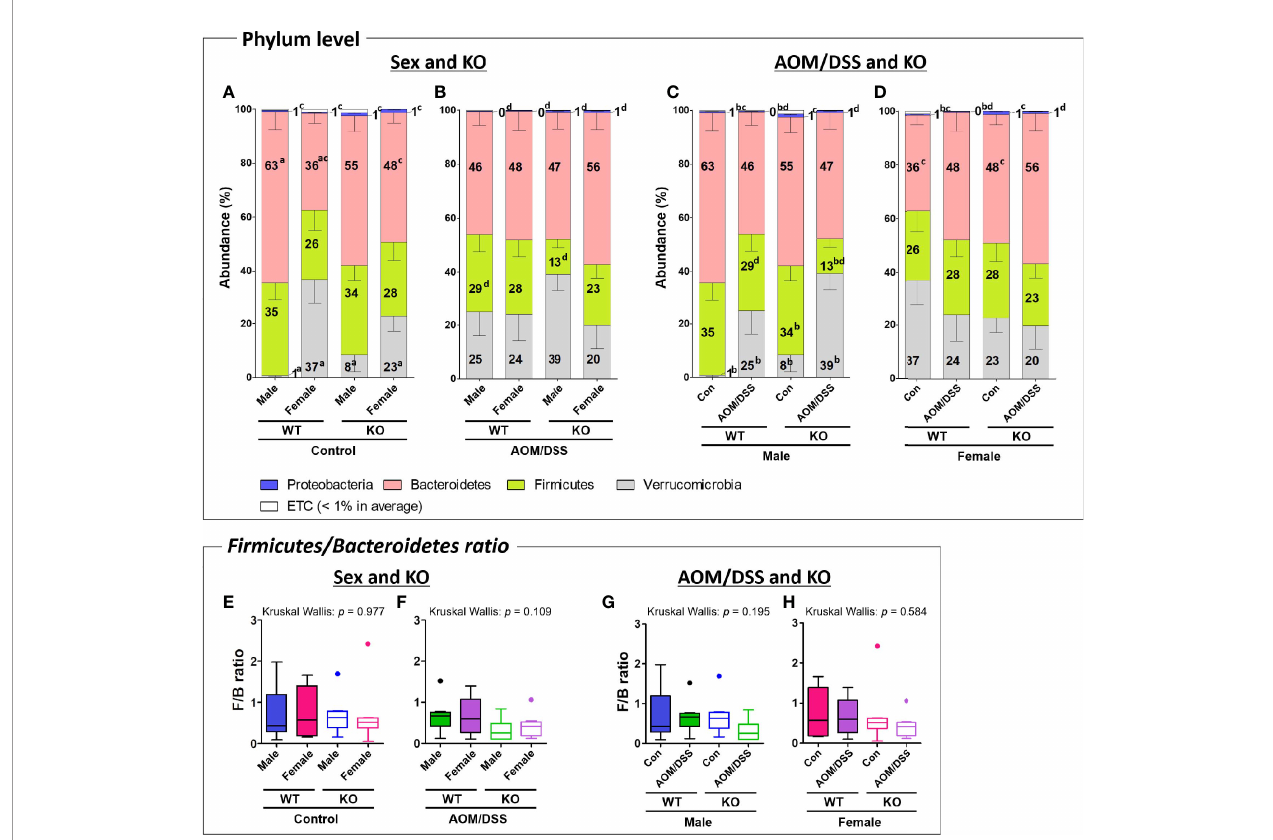
FIGURE 4 | Gut microbiota composition at the phylum level. (A – D) Taxonomic composition of fecal samples obtained from the groups with “ Sex and KO ” criteria (A, B) , as well as with “ AOM/DSS and KO ” criteria (C, D) . The abundance indicates the percentage of each phylum in total microorganisms. Stacked bars indicate mean ± SEM. Mann – Whitney U-test was used to analyze the difference between two independent groups in (A – D) . a p < 0.05, males vs . females; b p < 0.05, controls vs . AOM/DSS-treated groups; c p < 0.05, WT controls vs . Nrf2 KO controls; d p < 0.05, WT AOM/DSS-treated vs . Nrf2 KO AOM/DSS- treated. (E – H) Firmicutes/Bacteroidetes ratio calculated by dividing the abundance of Firmicutes with that of Bacteroidetes in the groups with “ Sex and KO ” criteria, as well as with “ AOM/DSS and KO ” criteria. Data are expressed as the mean ± SEM. Whiskers show the minimum and maximum values. The p -values calculated from the Kruskal – Wallis test is shown in the fi gure. WT, wild-type; Nrf2 KO, Nrf2 knockout; Con, control; AOM, azoxymethane; DSS, dextran sodium sulfate; SEM, standard error of